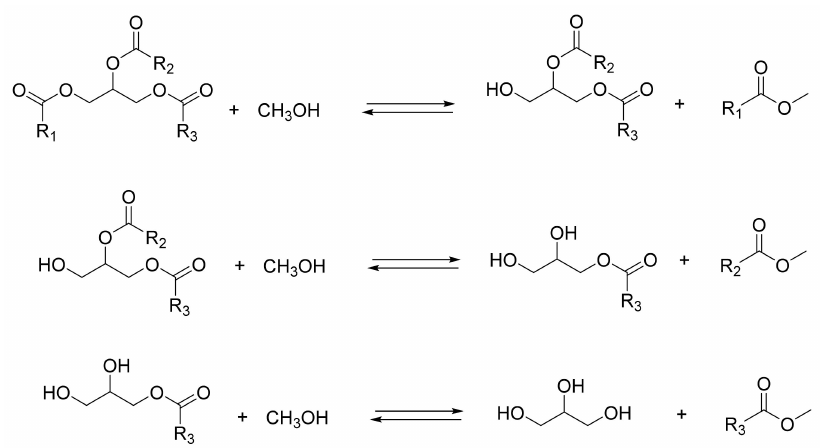
Scheme 1. General scheme of the transesterification reaction in the presence of